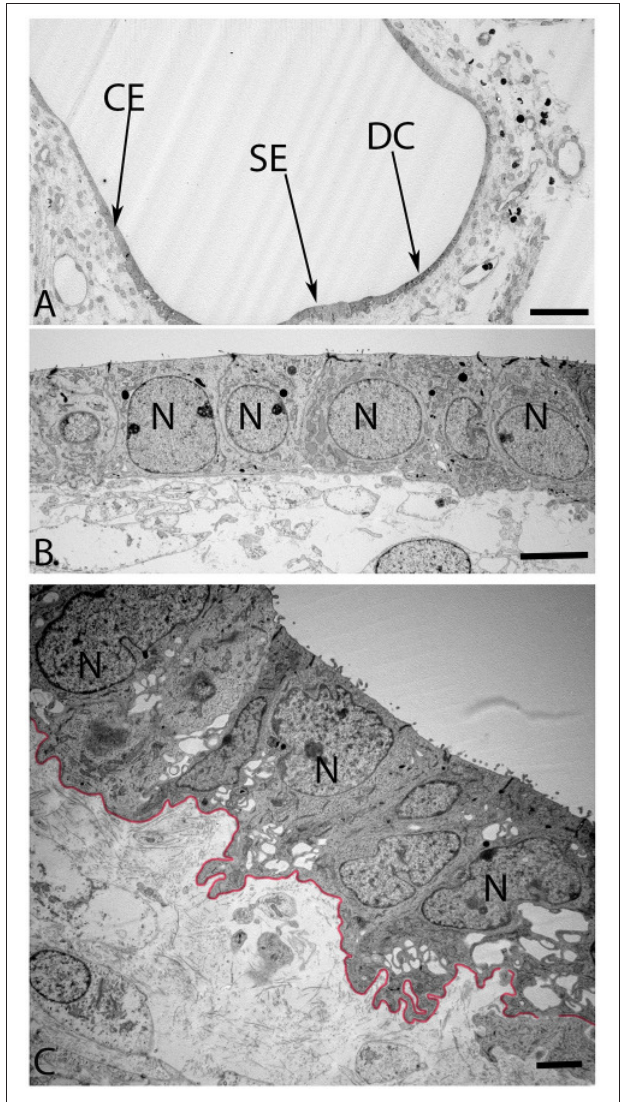
FIGURE 8 | Overview of the crista ampullaris in the human fetal VO at W12 in (A). The DC area of the cristae (arrow) is clearly distinct from both the lower portion of sensory epithelium (SE) close to the transitional zone (arrow) and the simple cuboidal epithelium (CE) (arrow). The cells in the CE (B) is single layered and uniformly sized while the DC (C) begin to develop their basal labyrinth with various spaces separated by a basal lamina (colored red) toward the mesothelial compartments. Large lobulated nuclei (N) placed in the upper portion of the cells further characterize these cells. Most of the cytoplasmic organelles are located in the upper two-thirds of the DC’s, including numerous irregular vacuoles. Deep infoldings of the lateral and basal plasmalemma divide the lower third of these cells into numerous foliate cytoplasmic compartments containing mitochondria (C) . Scale bar: 20 µ m (A) , 2 µ m (B) , and 1 µ m (C)